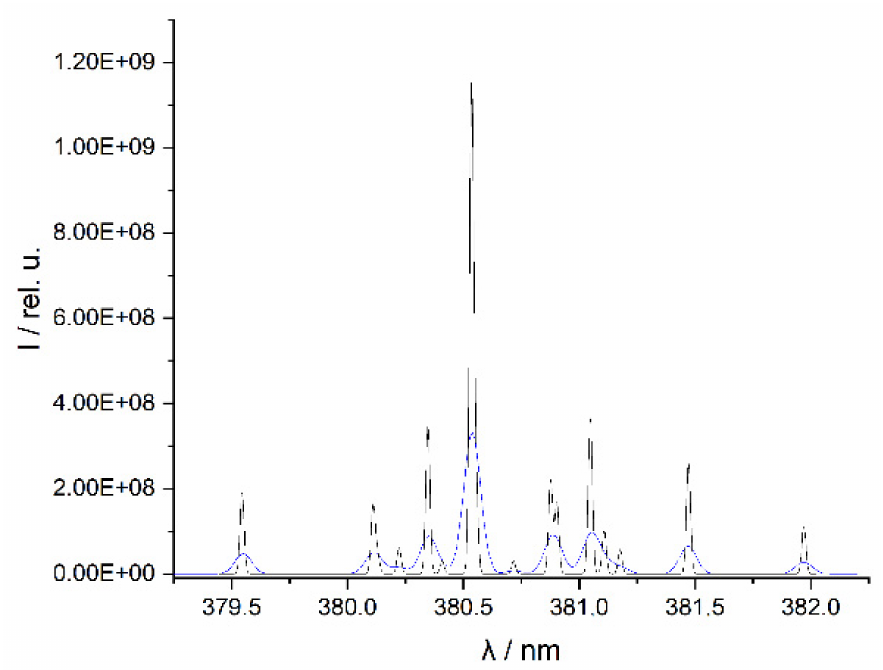
Figure 3. Spectra of Nd (element peak at 380.5 nm) simulated on the basis of the NIST database [39] with a spectral resolution of 100 pm (blue line) and 25 pm (black